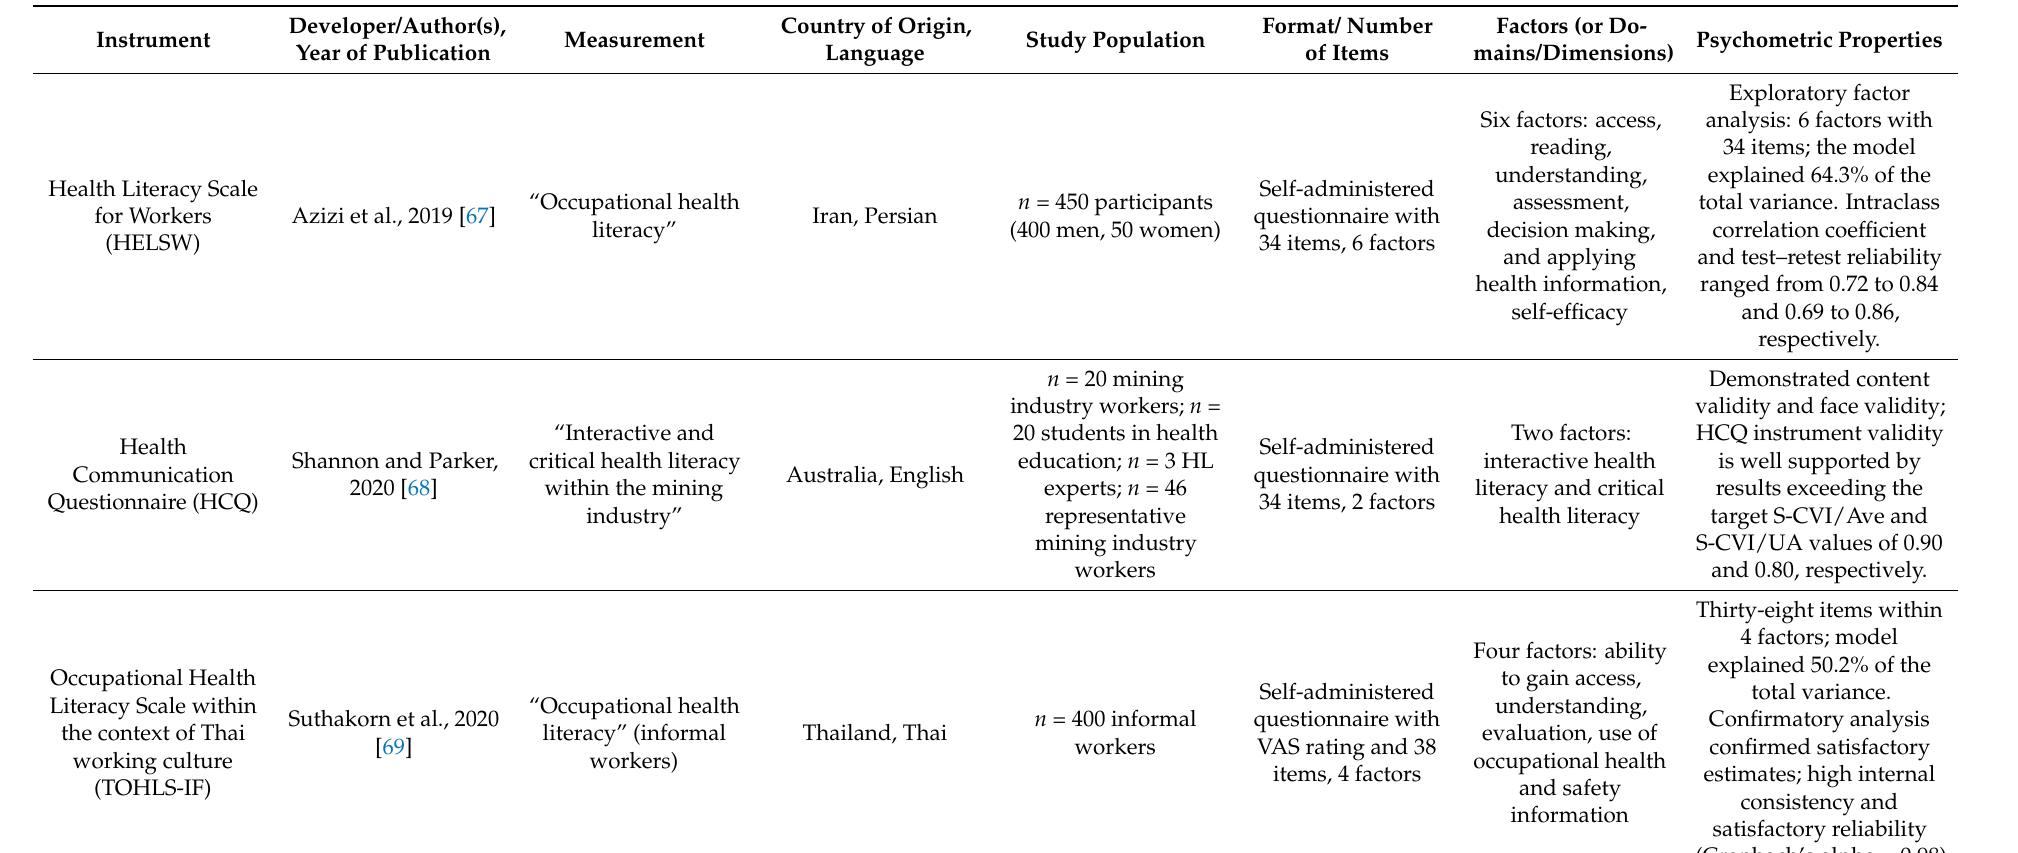
Table 4. Development and validation of measurement instruments for individual work-related health literacy (RQ